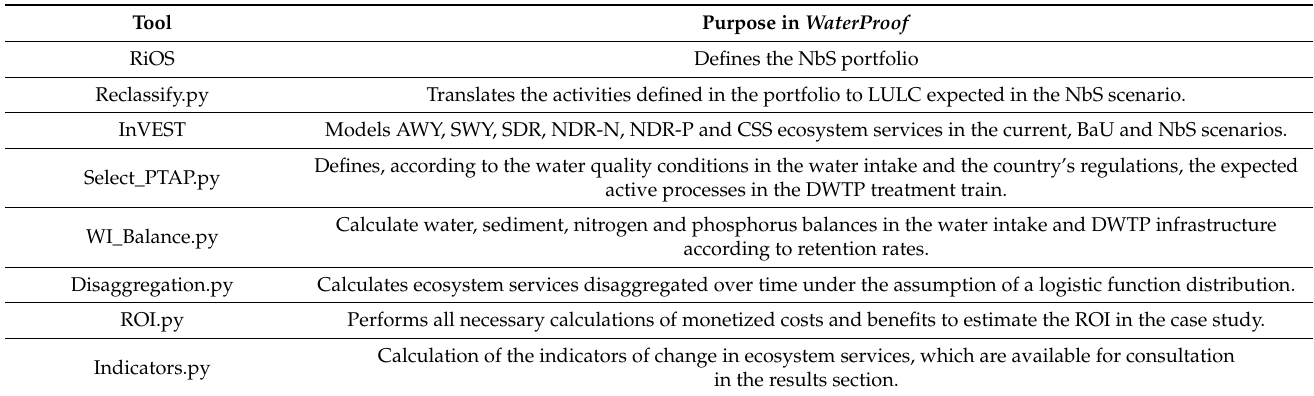
Table 6. Main modeling and analysis tools used in WaterProof .